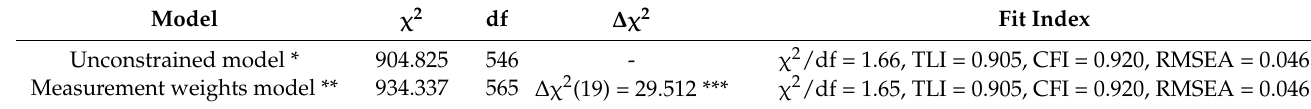
Table 8. Measurement equivalence analysis